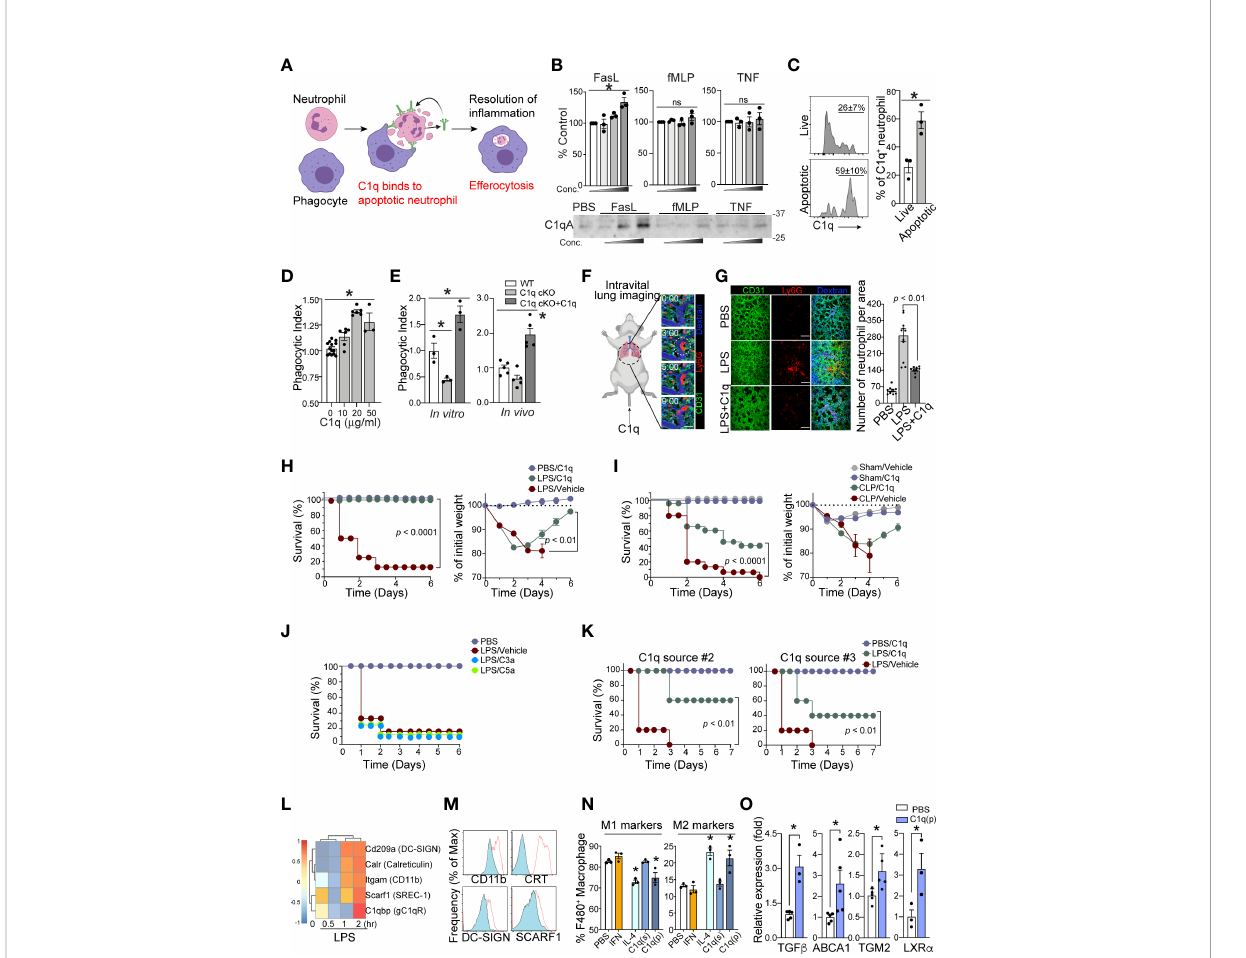
FIGURE 4 Neutrophil C1q is essential for resolution of in fl ammation. (A) , Neutrophil-speci fi c C1q expression is essential for proper efferocytosis of apoptotic neutrophils by local resident macrophage, leading to resolution of infection and survival. Without C1q, apoptotic neutrophils build up causing prolonged in fl ammation and therefore poorer prognosis and eventually, death. (B) , C1q secretion by neutrophils in response to FasL (0.2, 1, 5 m g/ml), fMLP (0.2, 1, 5 m M), or TNF- a (0.1, 1, 10 m g/ml) stimulation was determined by Western blot analysis of neutrophil supernatants with an C1q-speci fi c antibody. Upper: densitometry quanti fi cation. Bottom: Each panel shows one representative image of three replicated experiments. (C) , Left : MFIs of surface bound C1q on Annexin V - live ( top ) and Annexin V + apoptotic ( bottom ) human neutrophils treated with C1q. Right : Quanti fi cation of C1q expression as a percentage of total neutrophils on live and apoptotic cells (n = 3 per group). (D) , An increase in C1q concentration results in a similar increase in human apoptotic neutrophil clearance by a PMA-differentiated U937 monocyte cell line. n = 3-6. Data pooled from fi ve experiments. (E) , C1q cKO neutrophils exhibit impaired clearance by peritoneal macrophages, which is rescued by the addition of 10 m g of soluble C1q (n=3 per group). (F) , Representative real-time imaging of capillary obstruction with Ly6G + cells (red) in sepsis-induced acute lung injury model (Supplementary Video 3). The capillary fl ow (dextran, blue) and blood vessel (anti-CD31 antibody, green) are shown. White circle indicates newly entrapped neutrophil aggregates obstructing the capillary. Scale bars, 20 m m. (G) , Representative intravital imaging of the pulmonary microcirculation in the PBS, LPS, and LPS+C1q group. Scale bars, 100 m m in magni fi ed. Right: Comparisons of Ly6G + cell count among PBS, LPS, LPS+C1q groups. n = 3 – 4 mice per group. 3 – 4 fi elds of view per mouse, one-way ANOVA with post hoc Holm – Sidak ’ s multiple comparisons test. Data are presented as mean ± SEM. (H – J) , Survival curves ( left ) and sepsis severity ( right ) of WT mice treated with LPS (H, J) , or CLP (I) that received 20 m g of C1q, C3a, C5a, or vehicle 30 min prior to sepsis induction and again at 6h and 24h post sepsis induction. n = 3- 4 for PBS and n = 8 – 14 for per treatment group. (K) , Survival curves ( left ) and sepsis severity ( right ) of WT mice treated with LPS that received 20 m g of C3a or C5a 30 min prior to sepsis induction and again at 6h and 24h post sepsis induction. n = 7 per group. (L) , LPS-stimulated bone marrow derived macrophages exhibit a robust elevation in C1q receptor genes within 2h of activation (GEO dataset: GSE116220). (M) , MFI surface expression of C1qRs CD11b ( Itgam ), Calreticulin (CRT, Calr ), DC-SIGN ( Cd209a ), and SCARF-1 ( Srec-1 ) on peritoneal macrophages stimulated with LPS (red). n =3 (N) , Peritoneal macrophages were stimulated in vitro with either 40 ng/ml IFN- g , 1 m g/ml IL-4, 10 m g/ml soluble C1q(s), or 0.1 m g/ml plate-bound C1q (p) to induce M1 pro-in fl ammatory vs. M2 pro-resolving polarization. The frequency of M1 markers ( left ) was measured as the percentage of CD45 + /CD11b + /F4/80 + cells that were CD206 low /MerTK low /CD86 high while M2 markers ( right ) were CD206 high /MerTK high /CD86 low , n = 3 per condition, data representative of three separate experiments. (O) , Expression of the indicated genes in peritoneal macrophages stimulated in vitro with 0.1 m g/ml plate-bound C1q (P) was measured by qRT-PCR. Data are presented as mean ± SEM. Data were analyzed by ordinary one-way ANOVA with Tukey ’ s multiple comparison post-test in (B, E, N, O) , students t-test in (C) , Mantel-Cox and two-way ANOVA for (H – K) . (*P < 0.05), and by Welch ’ s one-way test for multiple group comparison for (D)